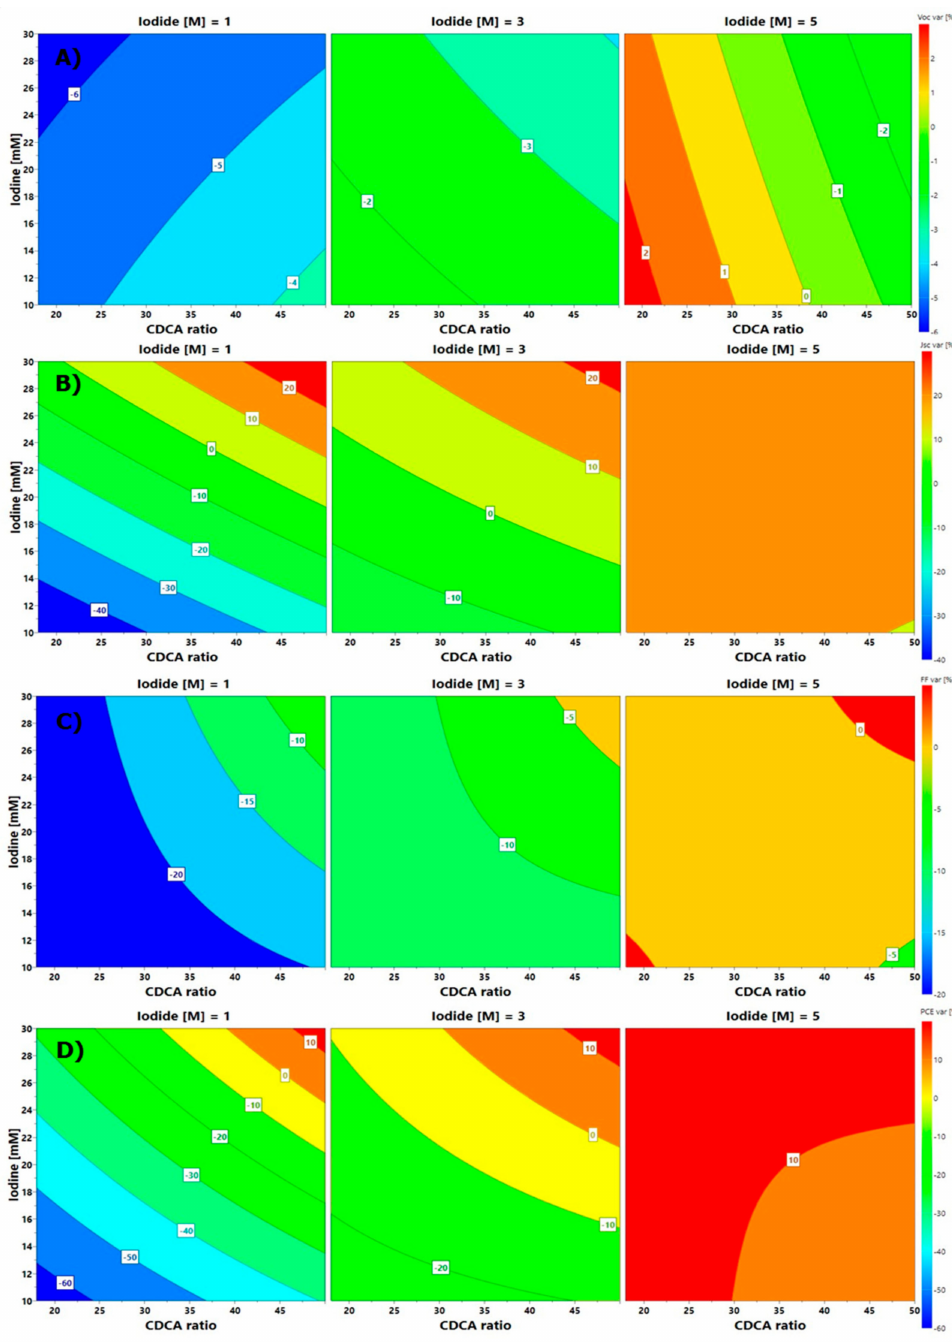
Figure 8. Contour plots for ( A ) V OC , ( B ) J SC , ( C ) FF and ( D ) PCE variation as a function of